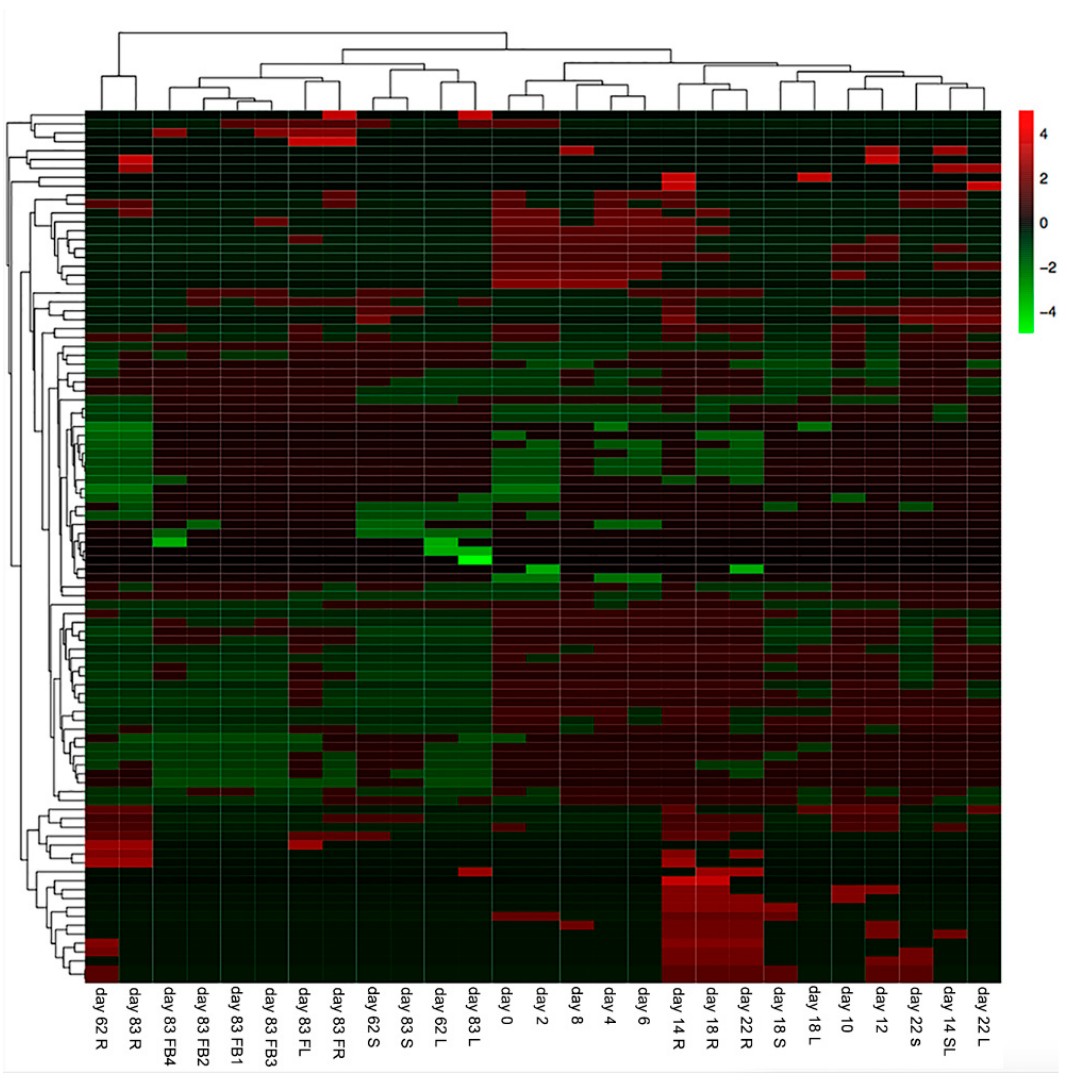
Figure 3. Heat map of the identified metabolites in different organs of S. baicalensis during different growth stages. R: the root of S. baicalensis ; S: the stem of S. baicalensis ; L: the leaves of S. baicalensis; SL: the leaves and stems of S. baicalensis ; FB1~FB4: the flower bud 1~flower bud 4 of S. baicalensis ; FL: the flowers of S. baicalensis ; Fr: the fruits of S. baicalensis .